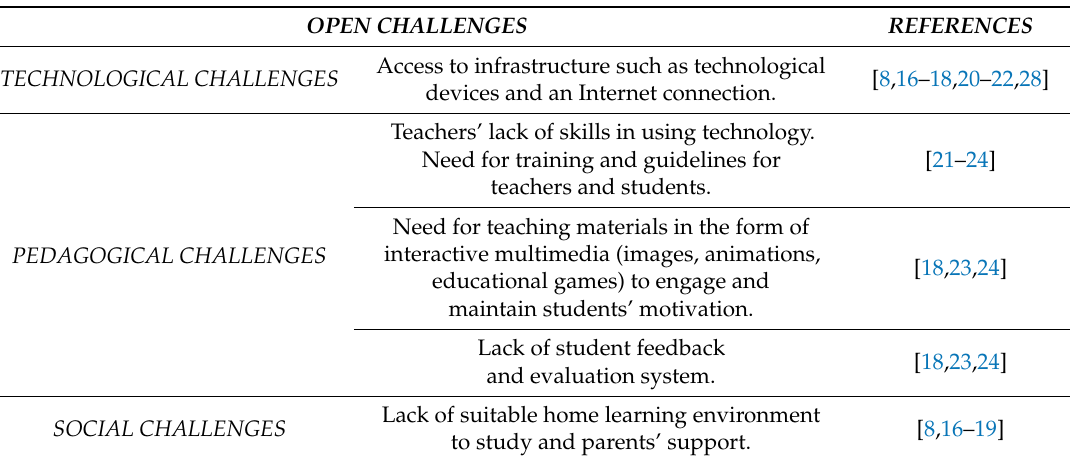
Table 1. Open challenges of online